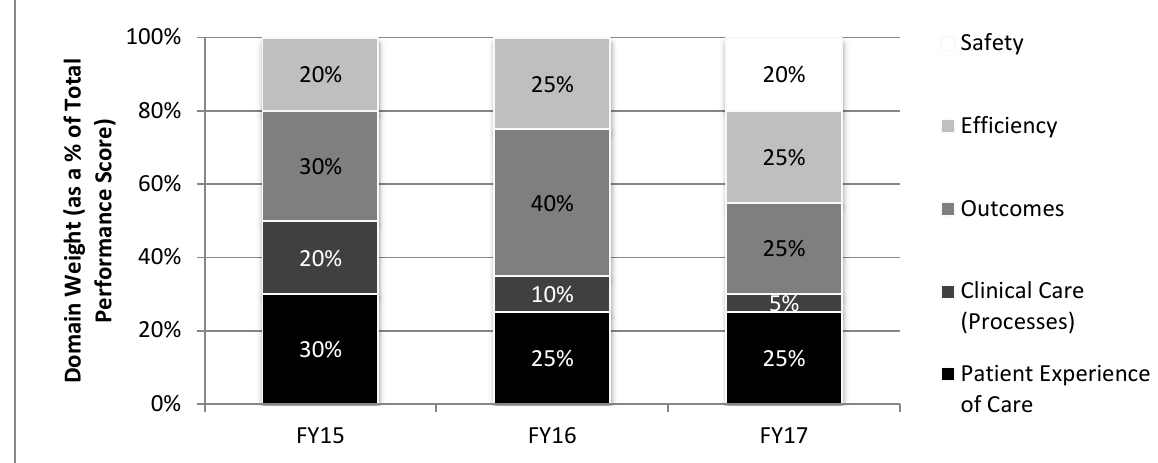
Figure 7.1. HVBP Domains and Domain Weights, FY